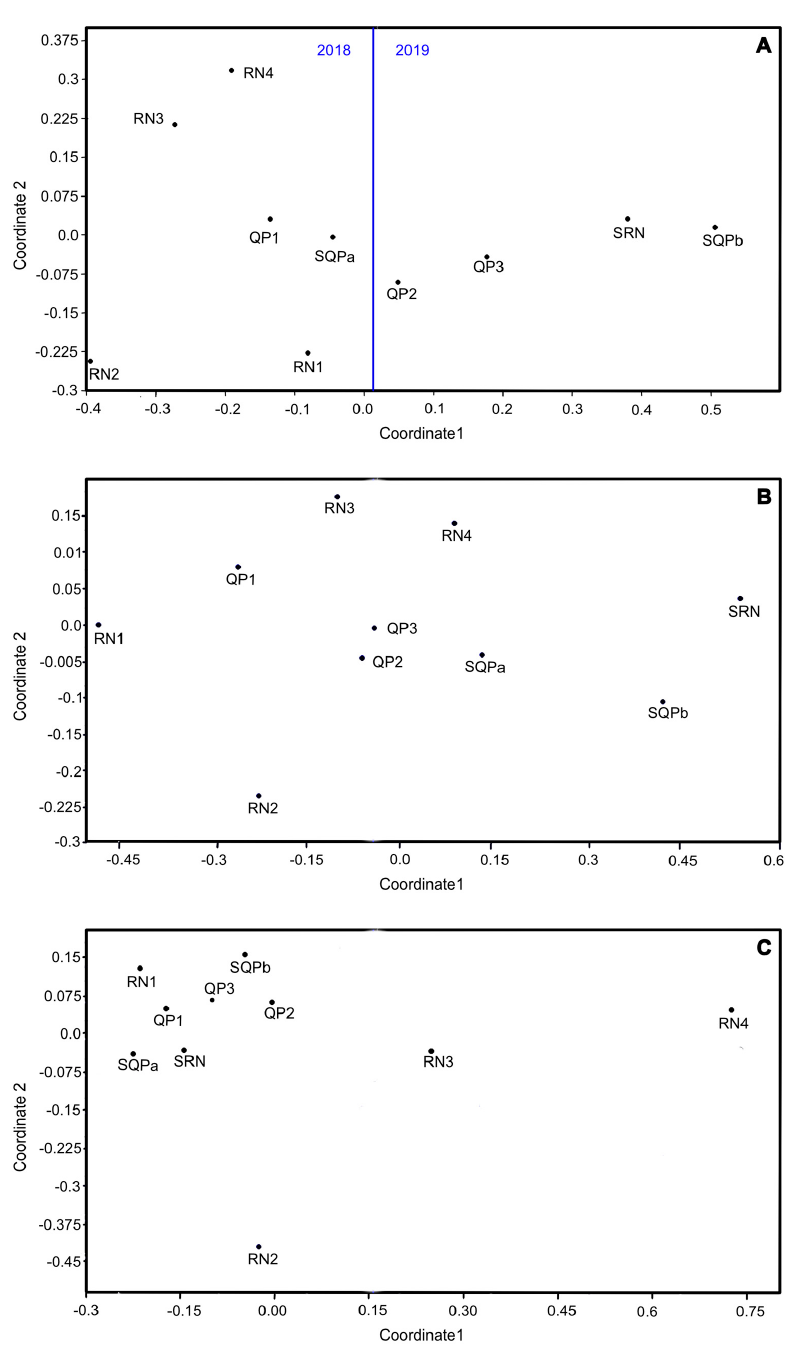
Figure 6. The NMSD analysis of the total amount of species collected ( A ), excluding singleton and doubleton species ( B ) and SD species by their own ( C ) in the studied forest sites (NNP, Podlaskie, North-East Poland).